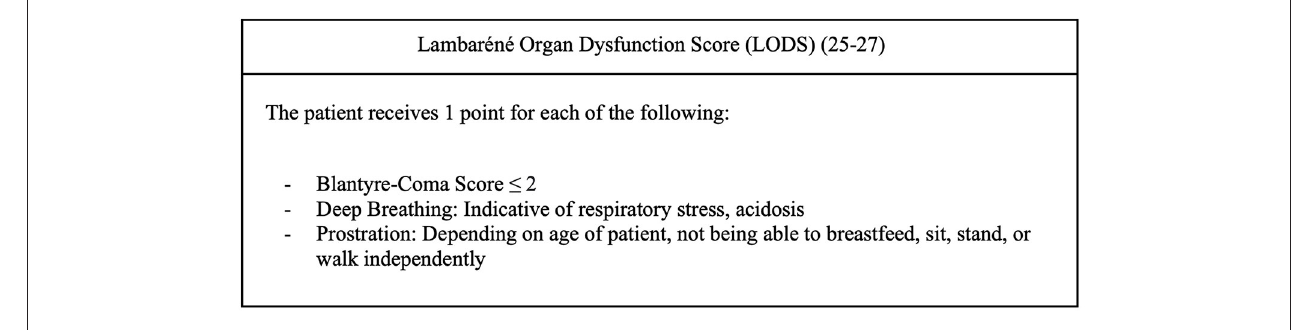
FIGURE 3 | LODS criteria.